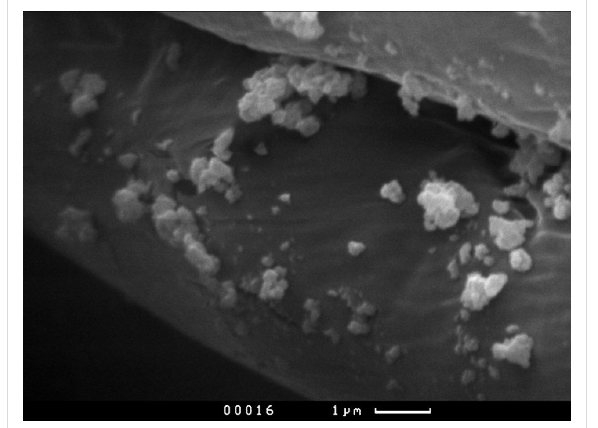
Figure 6: A SEM image of the coated textile fibres. The scale bar is 1 μ